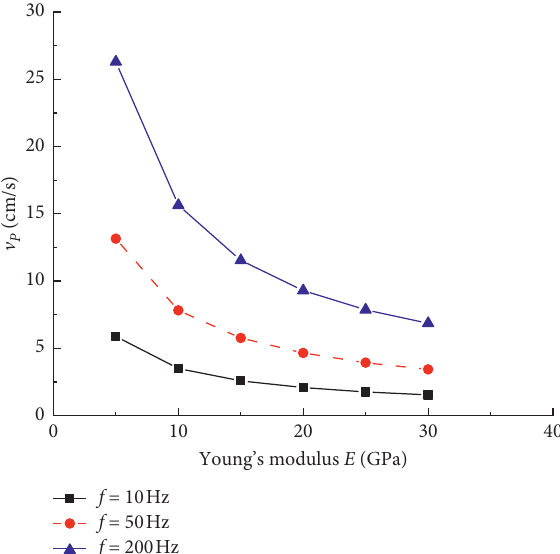
Figure 6: Variation of v v � 0.25.